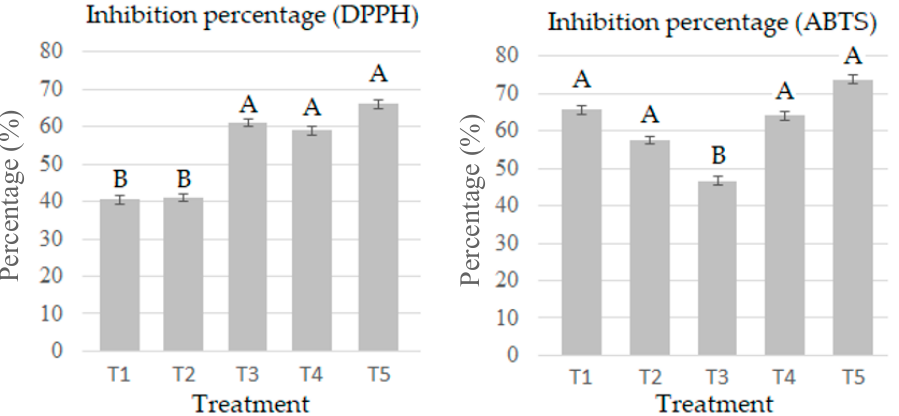
Figure 5. Inhibition percentage by DPPH and ABTS in P. djamor in the five treatments. The bars indicate the mean of each experiment in triplicate with SE. Different letters indicate significant difference (T-Student p ≤ 0.05).